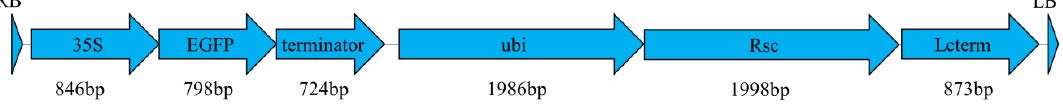
Figure 5. Organization of the binary plasmid used for Agrobacterium -mediated transformation. LB, left border; RB, right border. The egfp gene was used as a visual marker for selection and was driven by the CaMV35S (35S) promoter. The reporter regulator gene ( Rsc ) was controlled by the maize polyubiquitin gene ( ubi ) promoter.